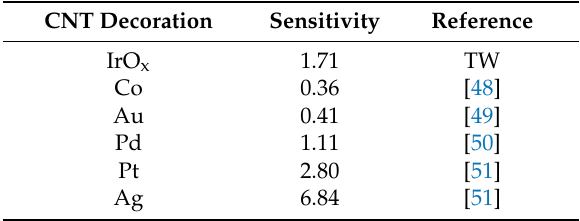
Figure S1: summary of IrO x NPs synthesis, Figure S2: Gas testing chamber and design of sensor used, Figure S3: TEM-EDXS spectrum of the IrO x -MWCNT sample, Figure S4: Acetaldehyde detection, Figure S5: Response